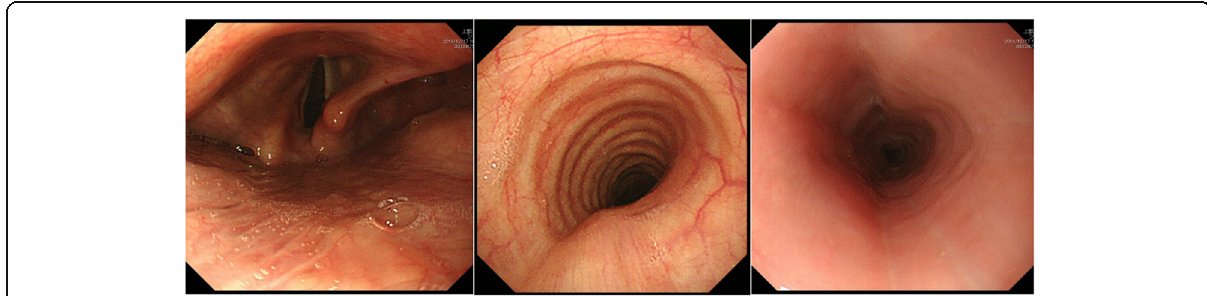
Fig. 3 Endoscopic findings. Right vocal code paralysis and tracheal/esophageal deformation were detected through endoscope images. No abnormality was found in the tracheal